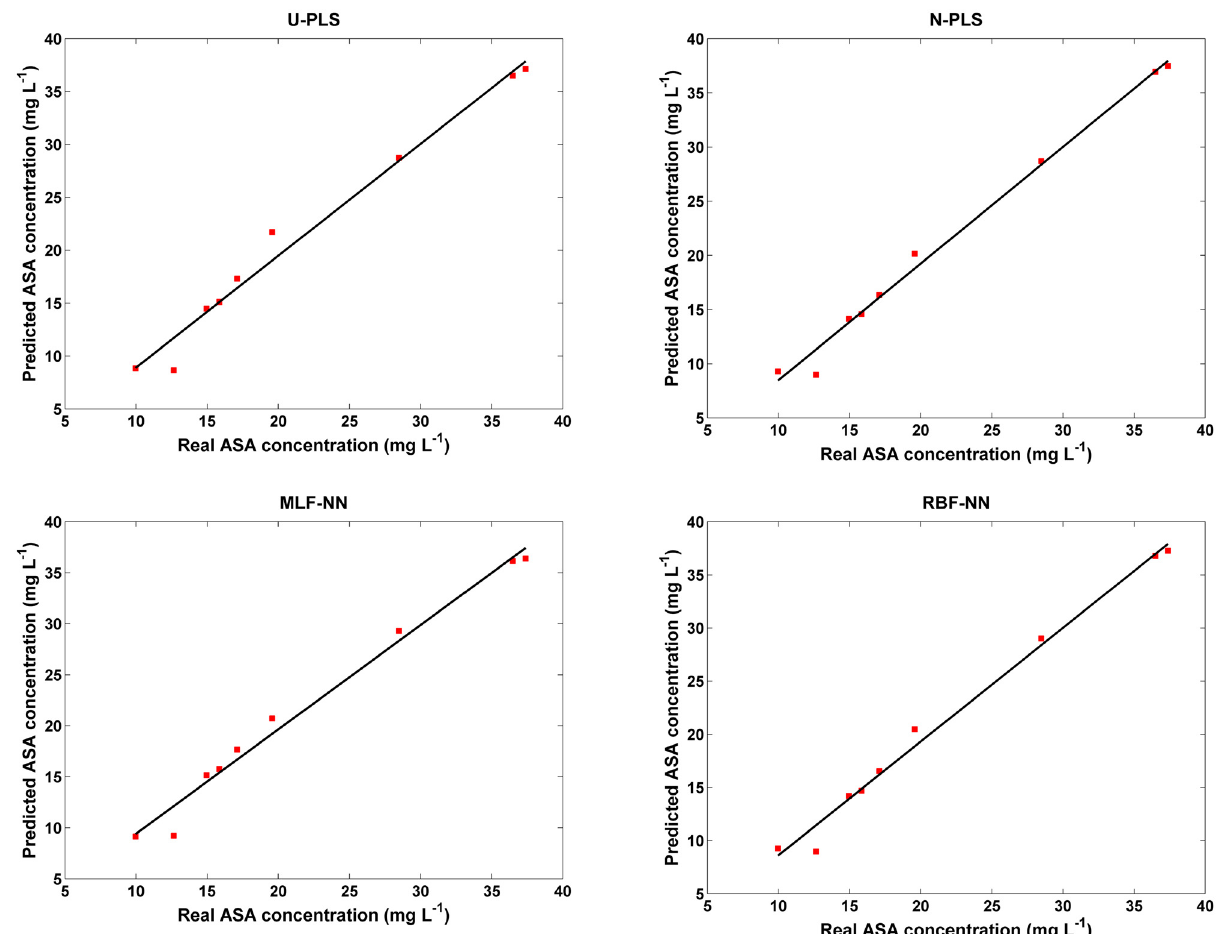
Figure 10. Plot of the predicted ASA concentration values against the real concentration values.